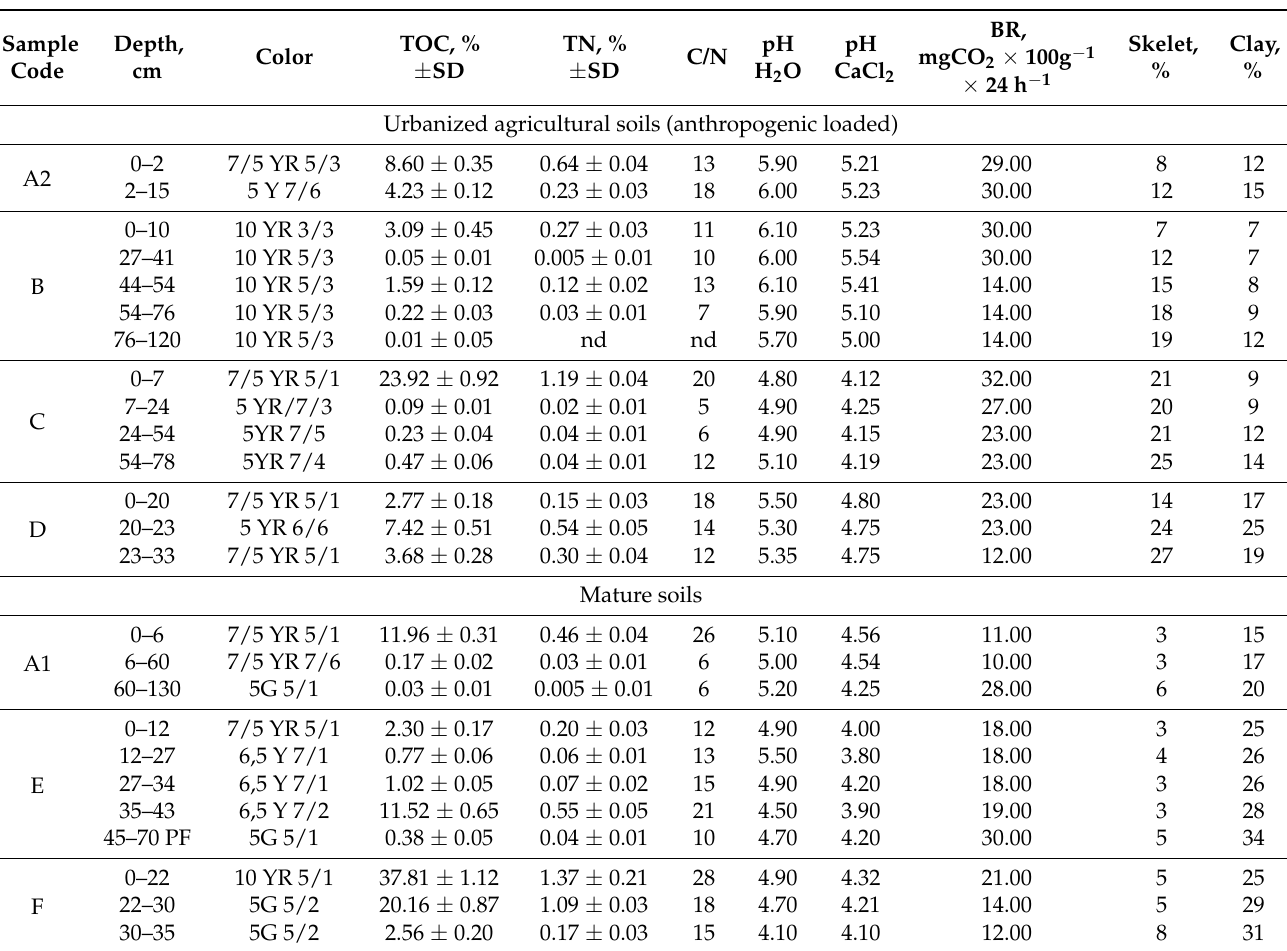
Table 3. Key soil